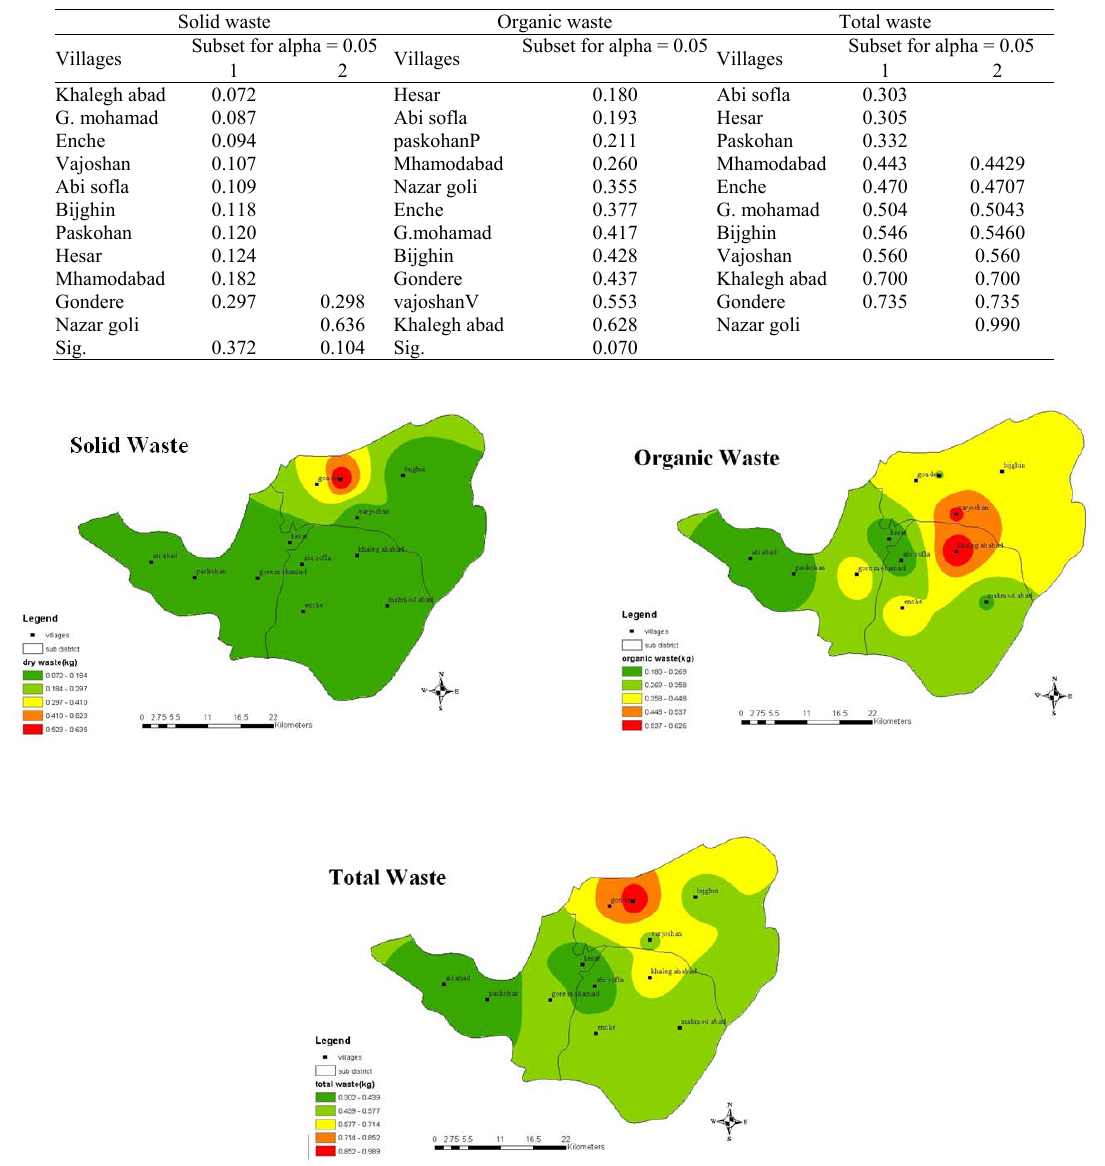
Fig. 3: Waste generation spatial interpolation in the study area